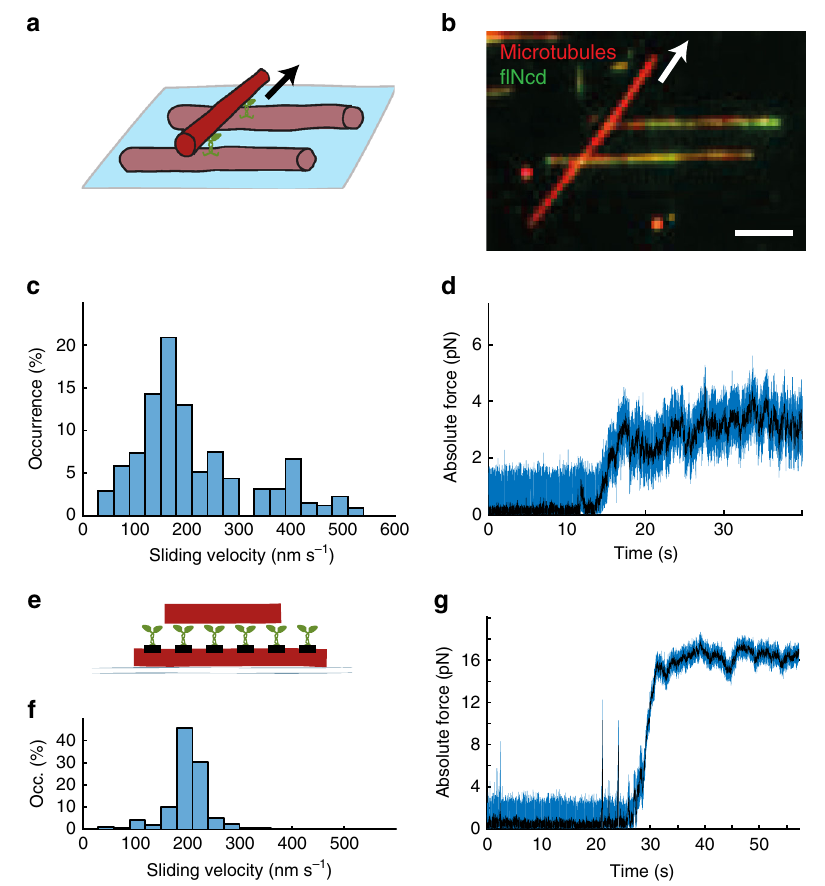
Fig. 3 Restricting the tail diffusion restores pN-range forces. a Depiction of non-aligned microtubules crosslinked by fl Ncd at an angle. The interaction with two surface-immobilized microtubules prevented the transported microtubule from aligning with either surface-immobilized microtubule. b Micrograph of non-aligned crosslinked microtubules; scale bar 5 µ m. c Velocity distribution of non-aligned microtubules transported by fl Ncd without external load ( N = 83). d Characteristic force trace for a microsphere, which was attached to a non-aligned microtubule that was transported by fl Ncd. The plotted force is absolute force. e Depiction of Ncd Δ tail statically anchored on microtubules, transporting microtubules. f Velocity distribution of microtubules transported by Ncd Δ tail statically anchored on microtubules ( N = 200). g Characteristic force trace for a microsphere, which was attached to microtubule that was transported by Ncd Δ tail statically anchored on another microtubules. The plotted force is absolute